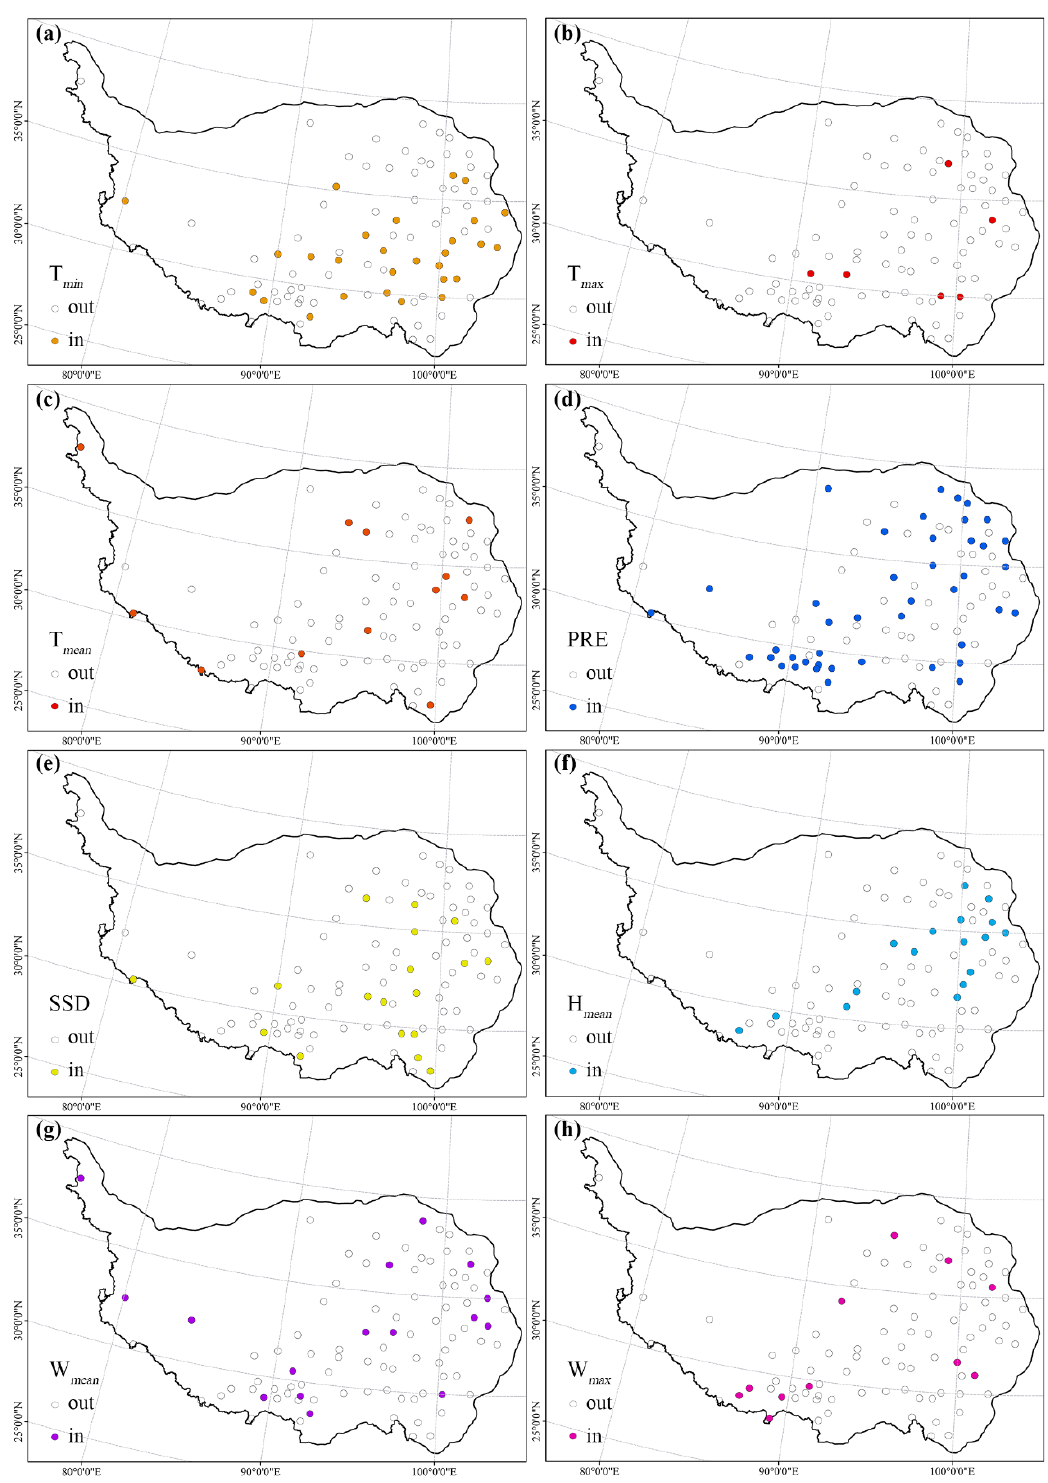
Figure 5. Spatial patterns of stations with different climatic variables ( a ) T min ( b ) T max ( c ) T mean ( d ) PRE ( e ) SSD ( f ) H mean ( g ) W mean ( h ) W max selected by the stepwise linear regression models for NDVI-retrieved MSD on the QTP. T min , T max , T mean , PRE, SSD, H mean , W mean , and W max denote the same meanings as in Figure 4. Circles in different colors represent meteorological stations with different climatic variables. “Out” means that the climate variable was not selected by the stepwise linear regression model, while “in” means that the climate variable was selected.